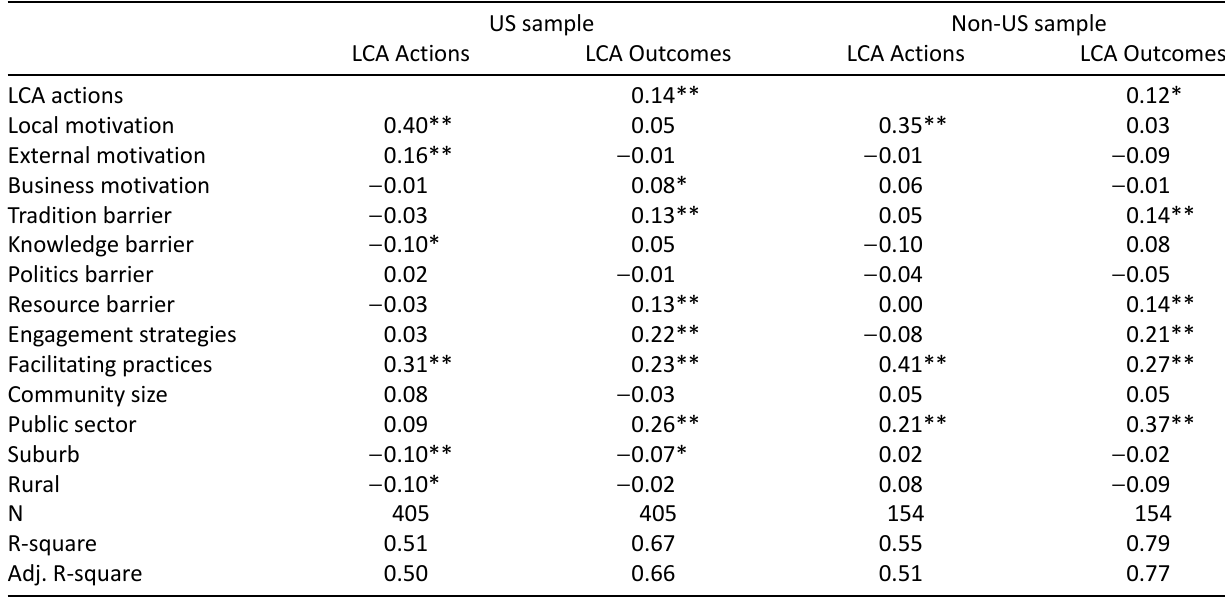
Table 6. OLS regression results: LCA actions and outcomes. Source: International Planner Engagement Survey (AARP, 2017).